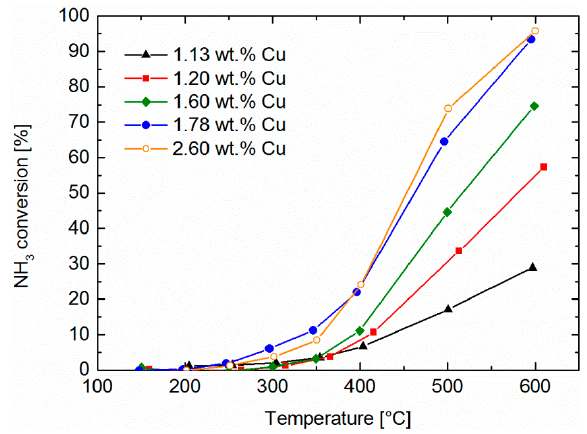
Figure 4. NH 3 conversion during NH 3 oxidation. Inlet: 400 ppm NH 3 , 8% O 2 , 5% H 2 O.